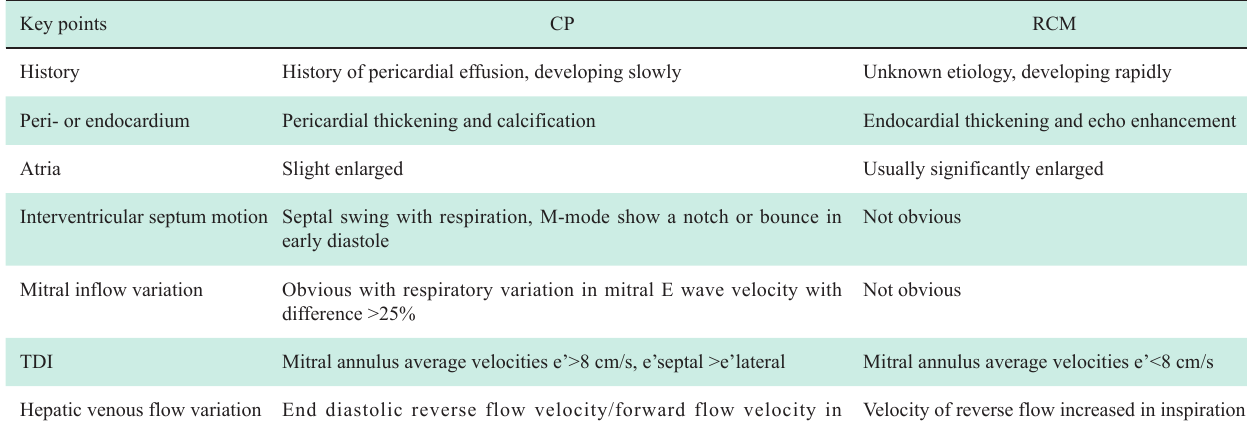
Table 3 key points to differentiate RCM from constrictive pericarditis